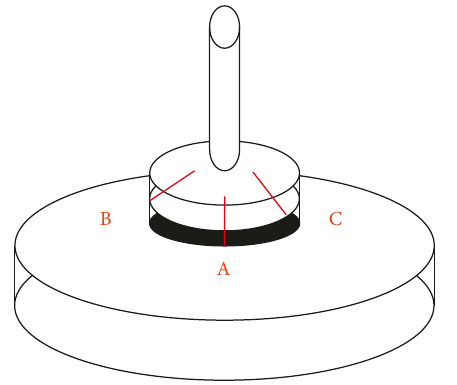
Figure 1: Dynamic shear rheometer operation.